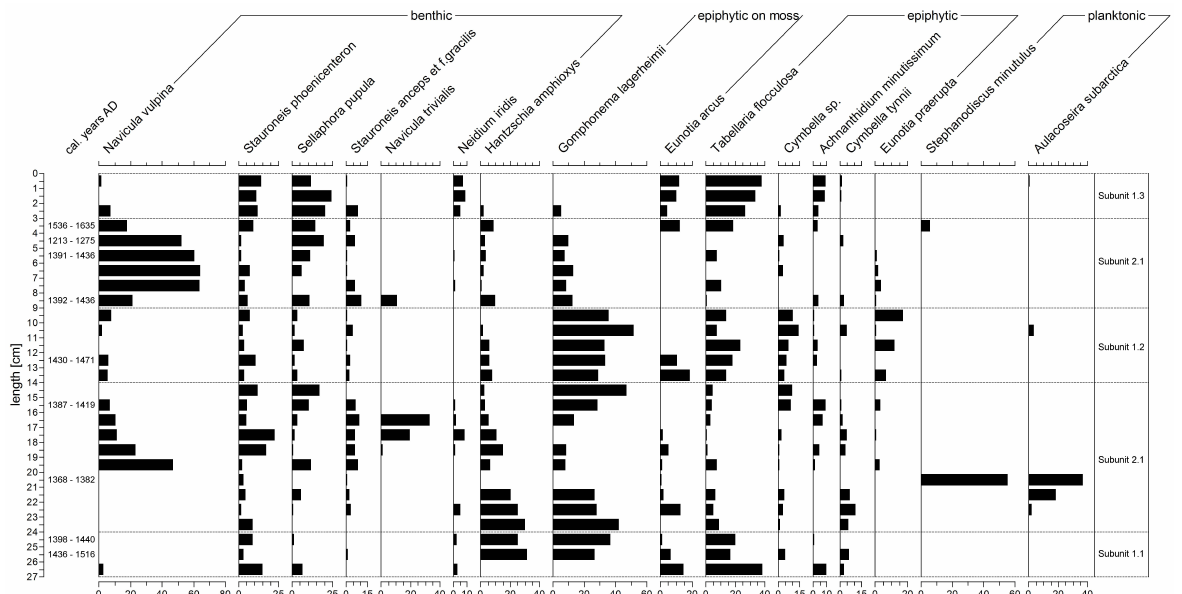
Fig. 8. Four ecological sections (benthic, epiphytic on moss, epiphytic and planktonic) showing the important species in the diatom assem- blage of Core